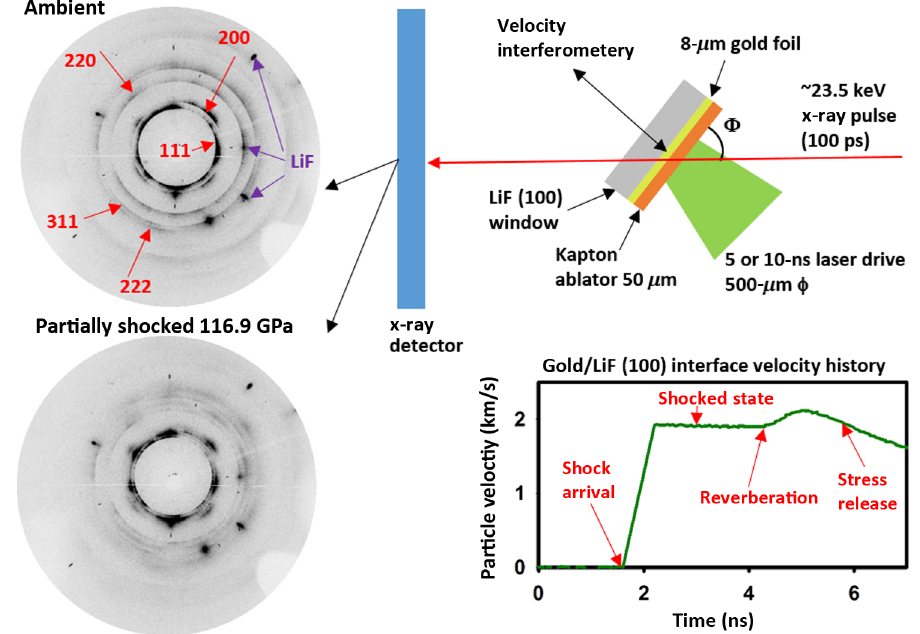
1. Schematic diagram for in situ nanosecond x-ray diffraction measurements in shock-compressed gold and representative results. A 351-nm laser pulse is focused on an aluminized Kapton ablator generating a shock wave which then propagates through the Au sample. XRD patterns corresponding to the ambient Au sample and to the Au sample partially shocked (35% of Au unshocked during XRD measurement) to 116.9 GPa are shown on the left. The diffraction rings are from the Au and the localized spots are from the single crystal LiF window; a few of the LiF spots are identified in the ambient XRD pattern. The LiF spots are easily identified as they are the same in both XRD patterns because the shock wave had not yet entered the LiF window during the XRD measurement in the laser shock experiments. For the XRD pattern from the partially shocked gold, the diffraction signal from the unshocked portion of the gold is clearly visible in azimuthally integrated 1D line profiles as shown in the Supplemental Material. Laser interferometry is used to measure the gold/LiF window interface velocity from which the shock stress is calculated. Laser drive temporal pulse shapes result in states of constant stress behind the shock wave, as verified by the measured particle velocity